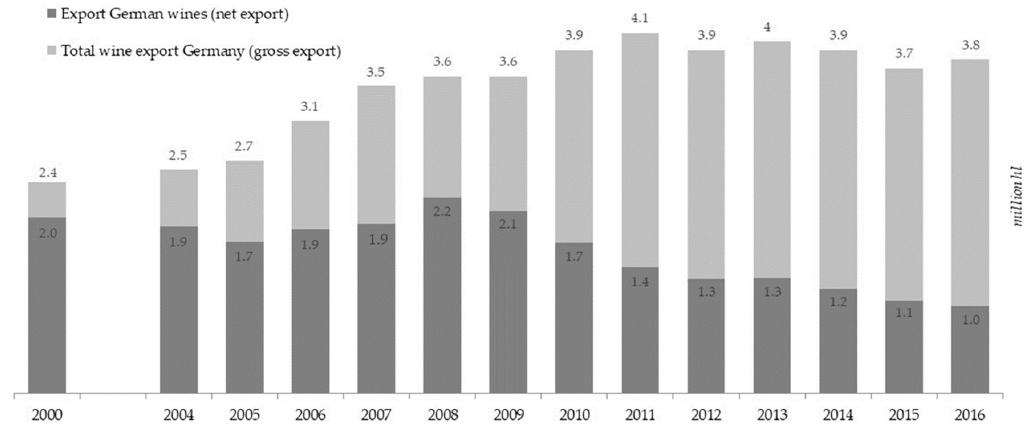
Figure 13. Wine exports (in million hectoliters).